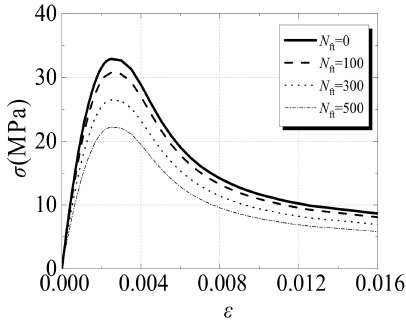
Figure 2. The stress–strain relationship of core concrete after freeze–thaw